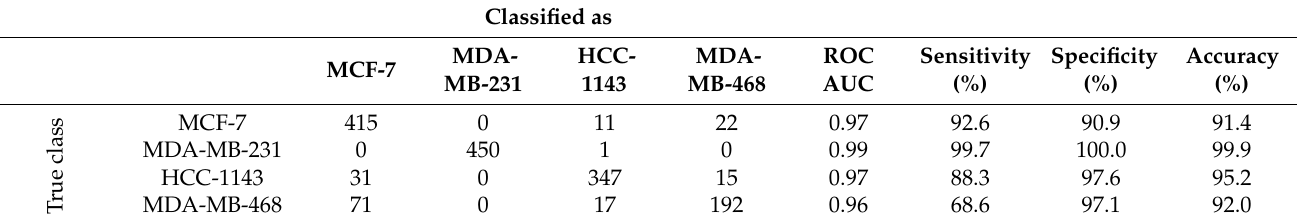
Table 2. Confusion matrix of RF classification model on independent FTIR data (fingerprint region) using the 25% held-out validation method, and respective performance metrics (ROC area, sensitivity, specificity and overall accuracy) of the model towards each group of samples (true class).